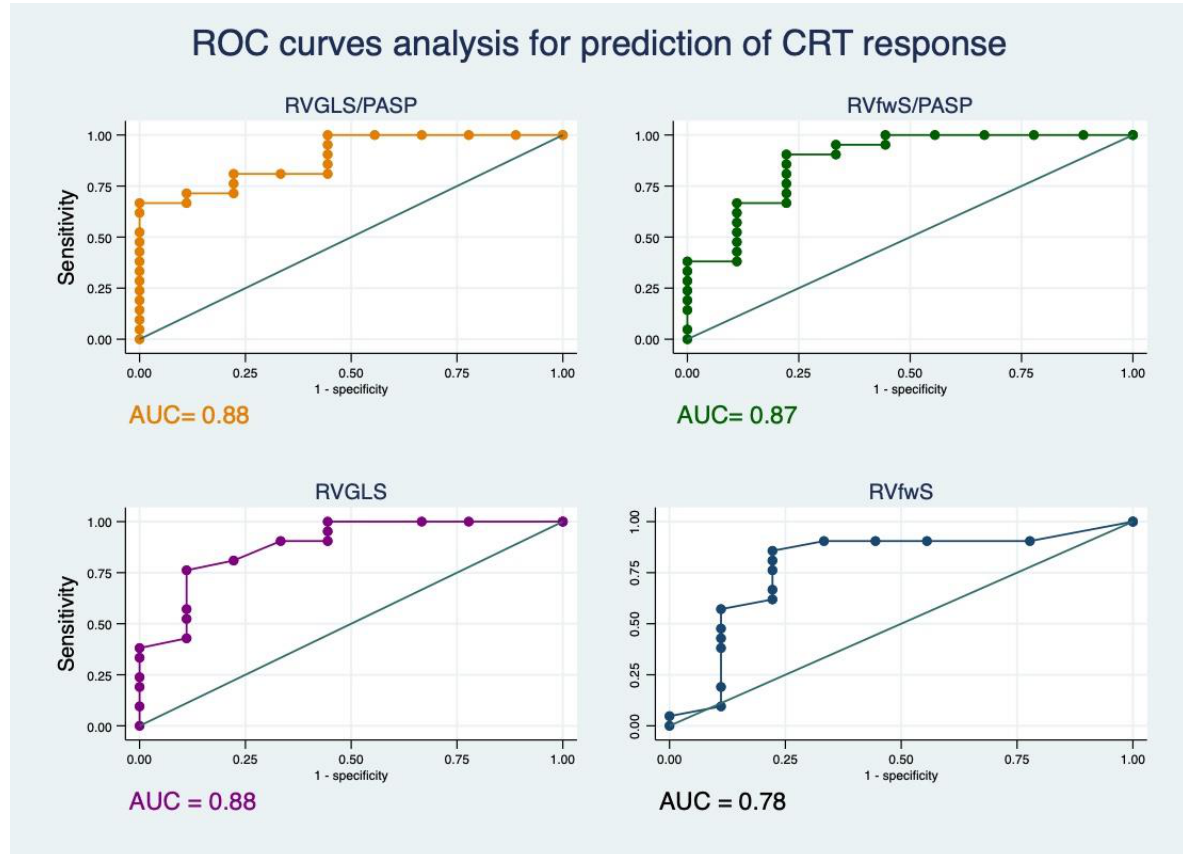
Figure 3. ROC curves analysis for prediction of CRT response for different variables. ROC: receiver operator characteristic, AUC: area under the curve, RVGLS: RV global longitudinal strain, PASP: pulmonary artery systolic pressure, RVfwS: RV free wall strain.